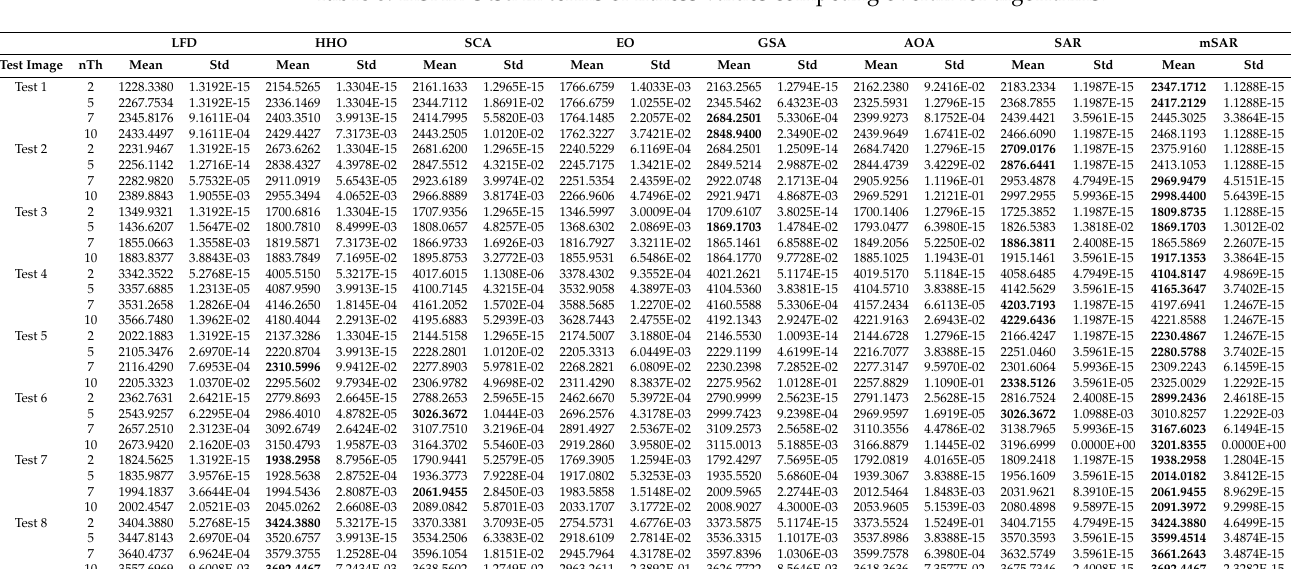
Table 8. mSAR Otsu in terms of fitness values competing overall for algorithms.